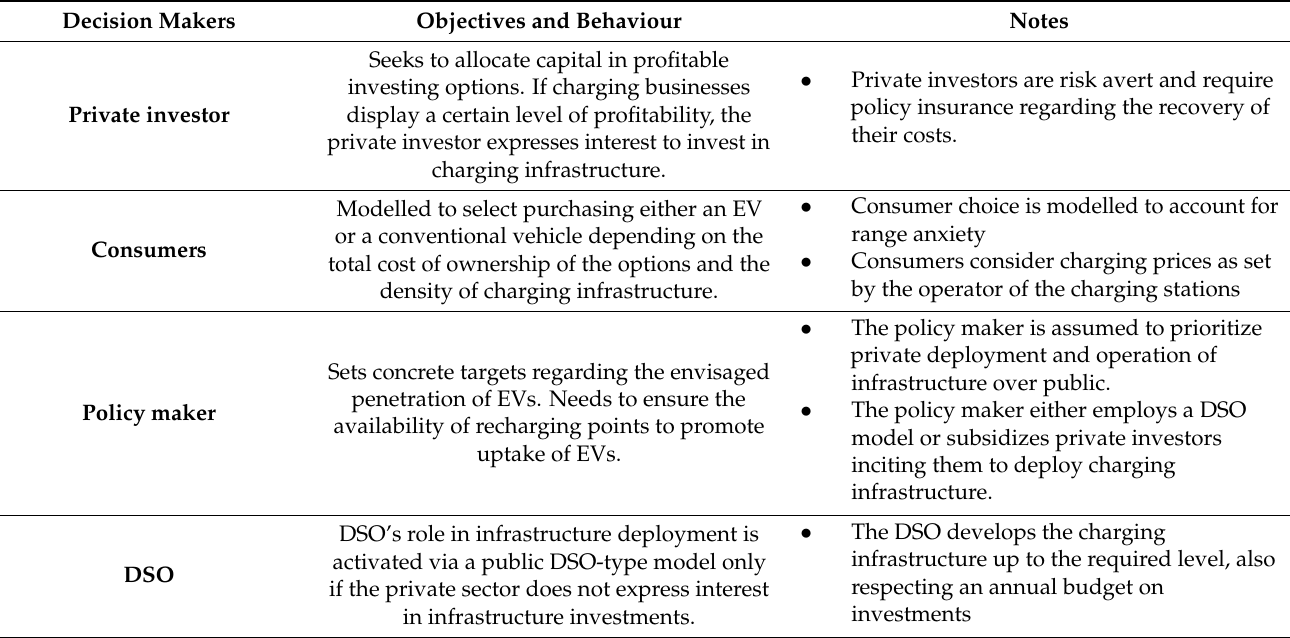
Table 2. Taxonomy of the decision makers of the electro-mobility system considered in